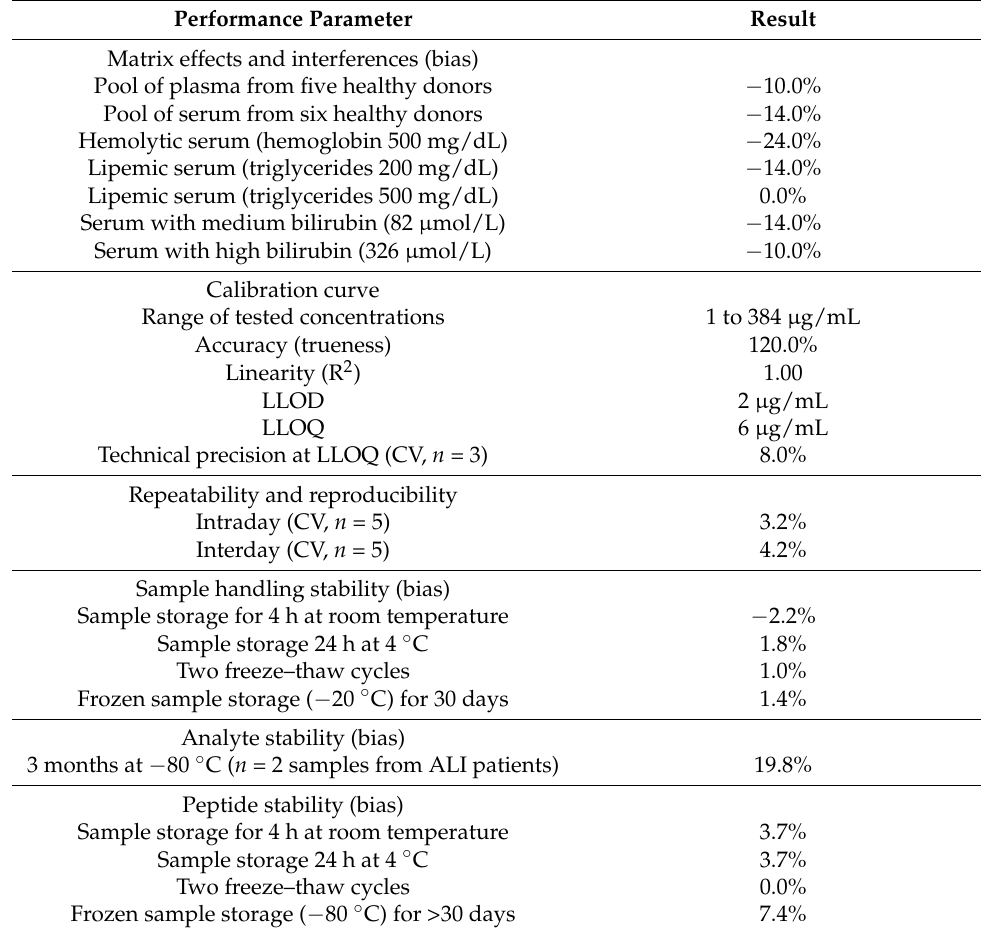
Table 2. Analytical performance of ADH1B targeted proteomics